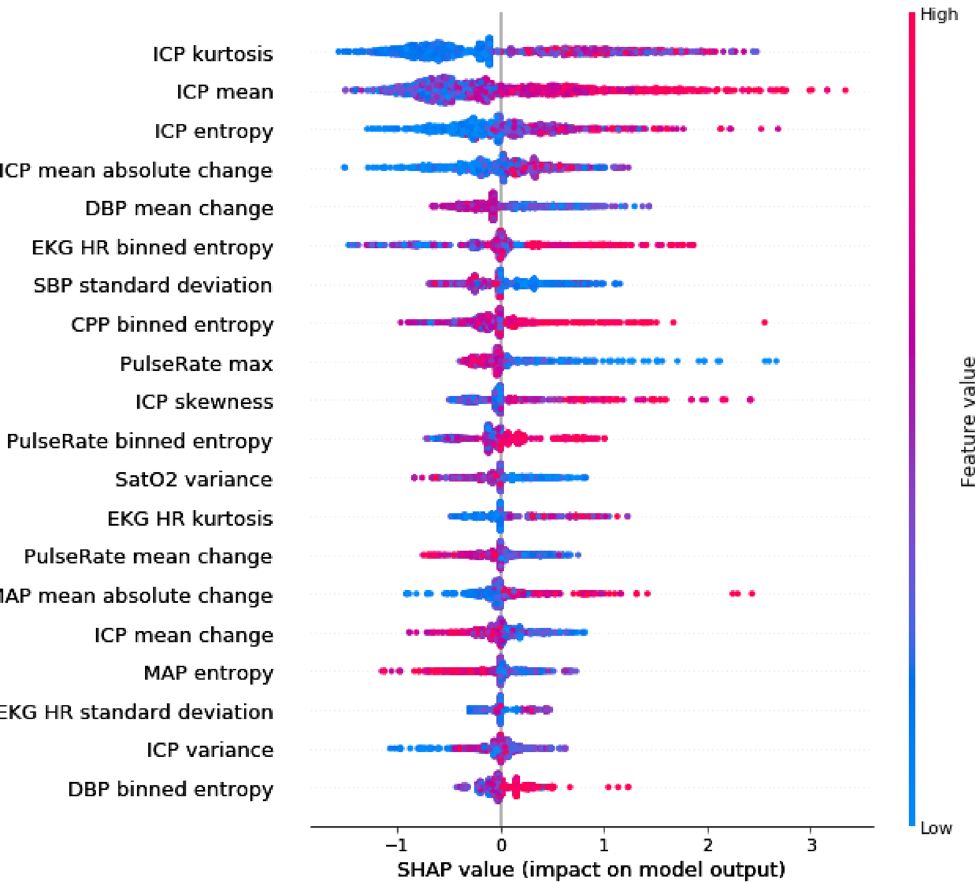
Figure 4. Average SHAP value plot, which assesses feature importance. Displayed in descending order of importance are the 20 features which were most contributory to the XGB model bundle performance with the 30-min prediction horizon, along with averaged SHAP values. For instance, low values (blue) of ICP kurtosis favor a prediction of “control” (negative SHAP values), whereas high values (red) of ICP mean favor a prediction of “event” (positive SHAP